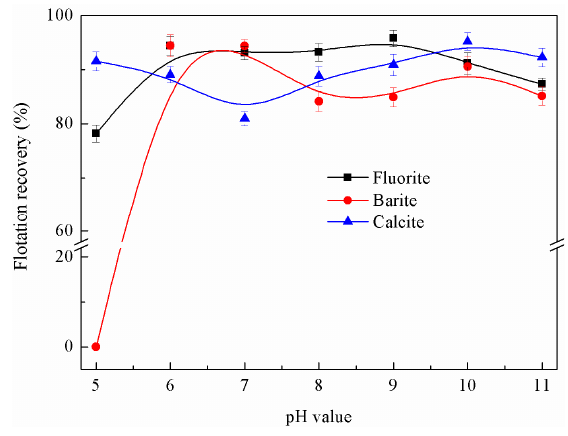
Figure 3. Effects of pH value on flotation recovery (sodium oleate dosage = 4 × 10 − 5 mol/L).